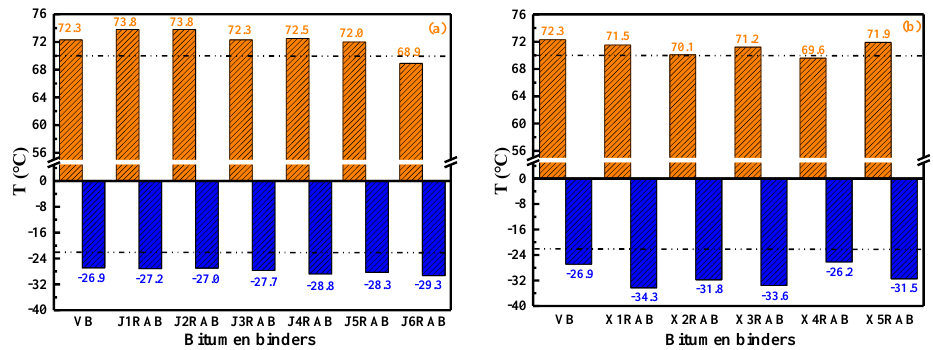
Figure 9. The Performance grade (PG) of rejuvenated binders.